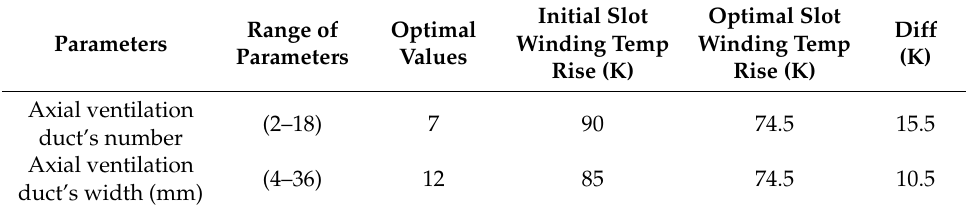
Table 8. Summary of the machine’s slot winding sensitivity analysis.